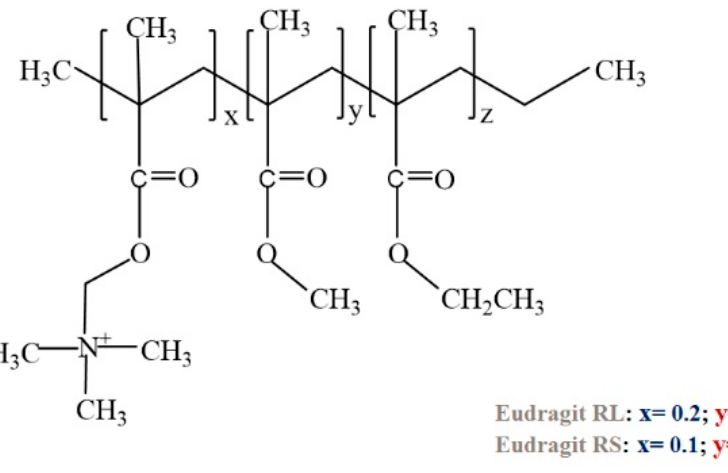
Figure 6. The chemical structure of Eudragit RL and RS.